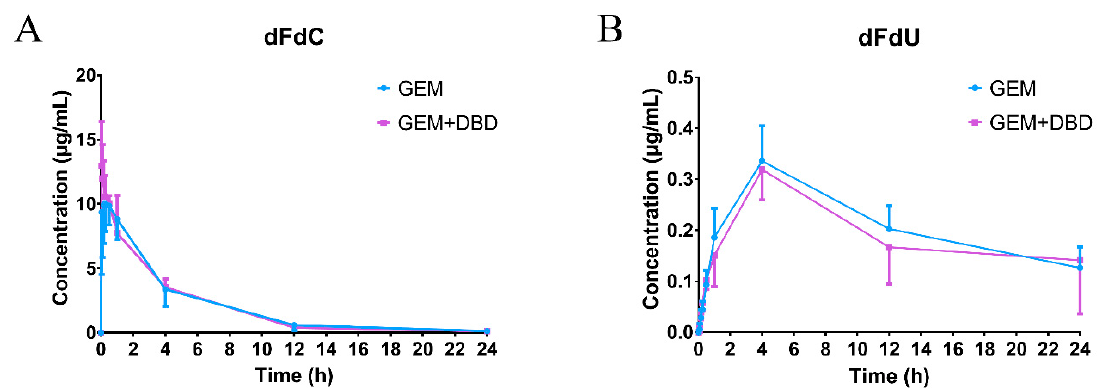
Figure 2. Concentration-time profiles of dFdC ( A ) and dFdU ( B ) in rat plasma after administration of GEM and DBD. Data were expressed as mean ± SD ( n = 10). Rats in the GEM group received a tail vein bolus intravenous administration of 50 mg / kg gemcitabine. In the GEM + DBD group, DBD was co-administered at the dose of 3.6 g / kg by intra gavage administration, whereas the GEM group was treated with saline.